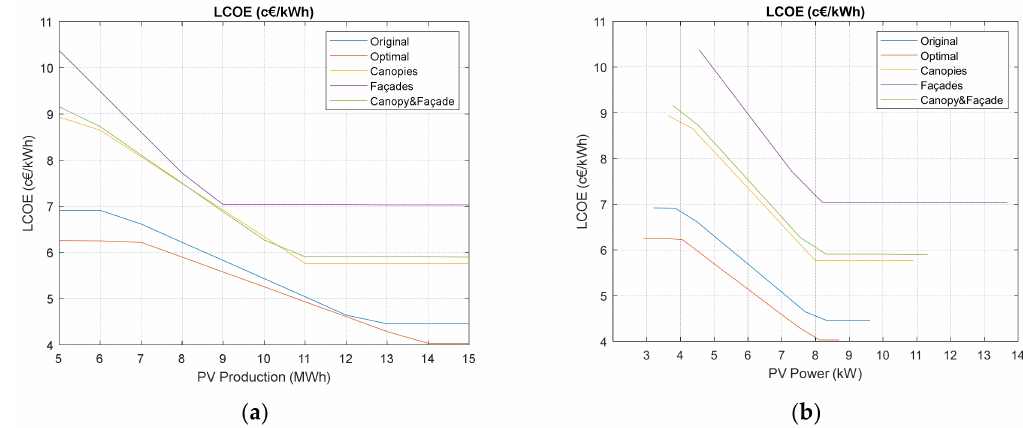
Figure 10. Levelized cost of electricity for all configurations. ( a ) LCOE vs. annual PV production; ( b ) LCOE vs. PV installed power.